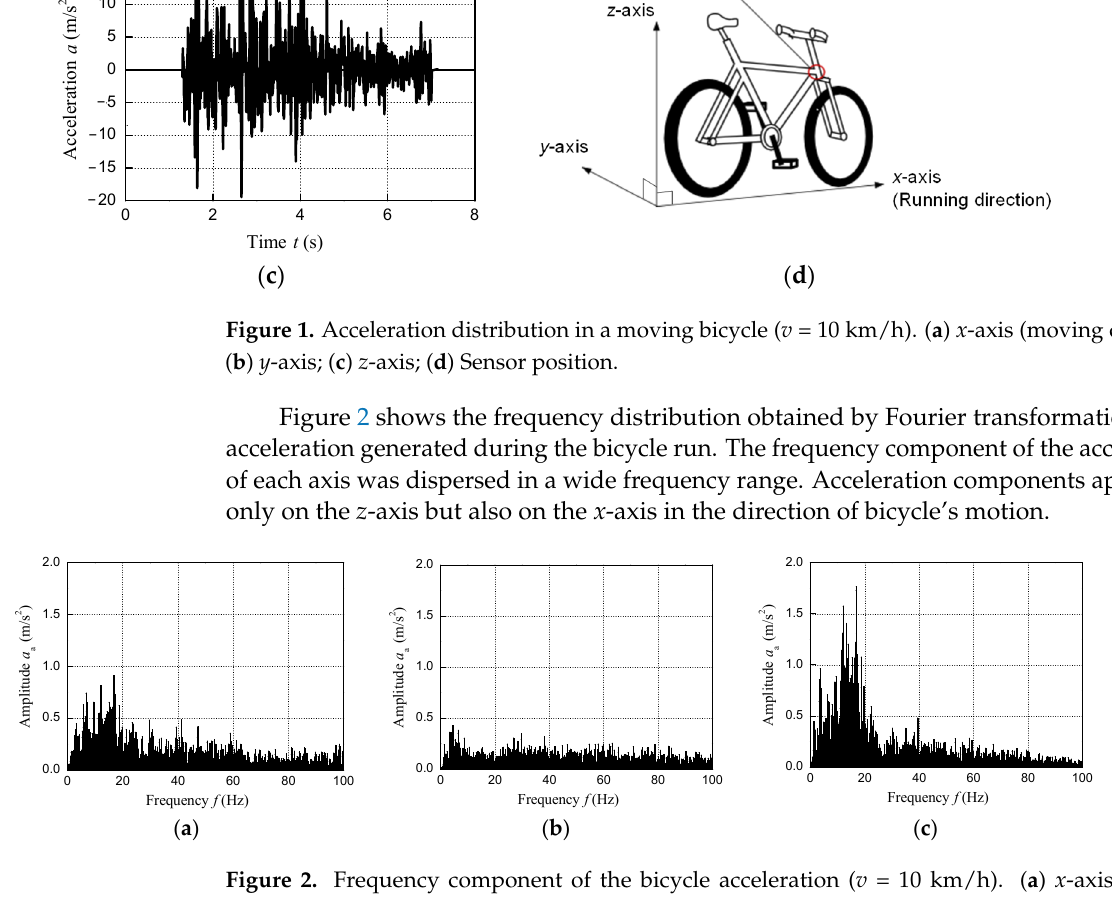
Figure 2. Frequency component of the bicycle acceleration ( v = 10 km/h). ( a ) x -axis (moving direction); ( b ) y -axis; ( c ) z -axis.